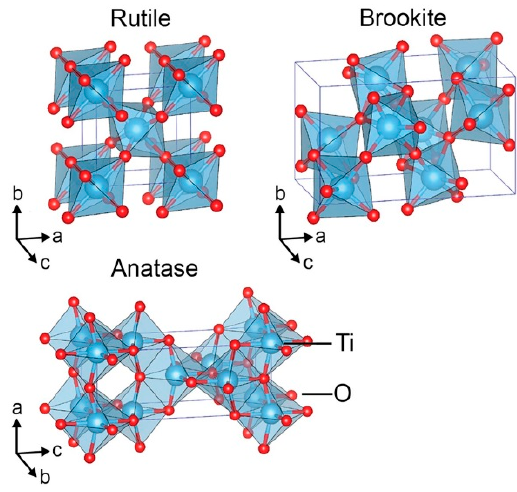
Figure 7. Crystal structures of TiO 2 . Reproduced from work in [67] .